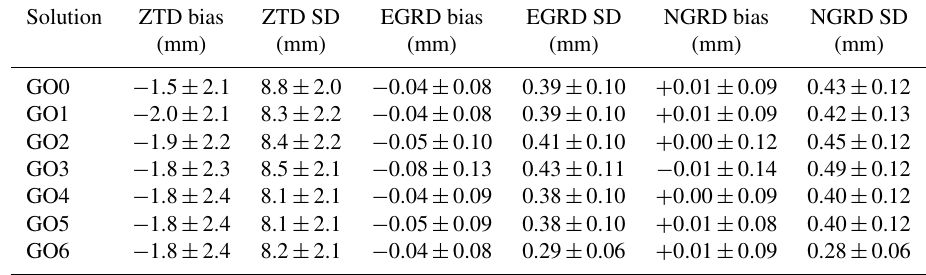
Table 4. Statistics (bias and standard deviations) of ZTD and tropospheric gradients from the seven reprocessing variants compared to those obtained from the ERA-Interim NWM reanalysis. In addition to the statistics, the 1 σ range over the ensemble of stations is provided. Solution ZTD bias ZTD SD EGRD bias EGRD SD NGRD